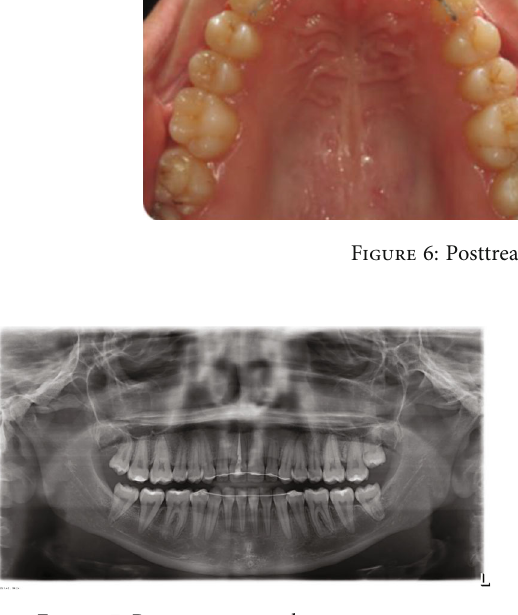
Figure 7: Posttreatment orthopantomogram.